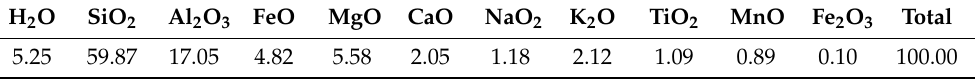
Table 1. Bulk rock composition, used for the calculation of the pseudosection in Figure 8, was analyzed (given in Weight %) and converted to the model system MnNCKFMASHTO (in mol.%).